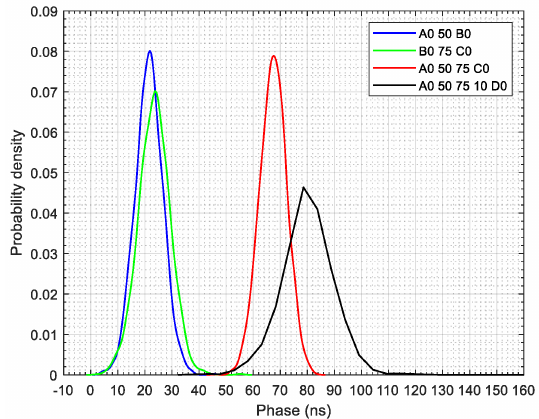
Figure 18. Distribution density for Sigma-Delta converters.